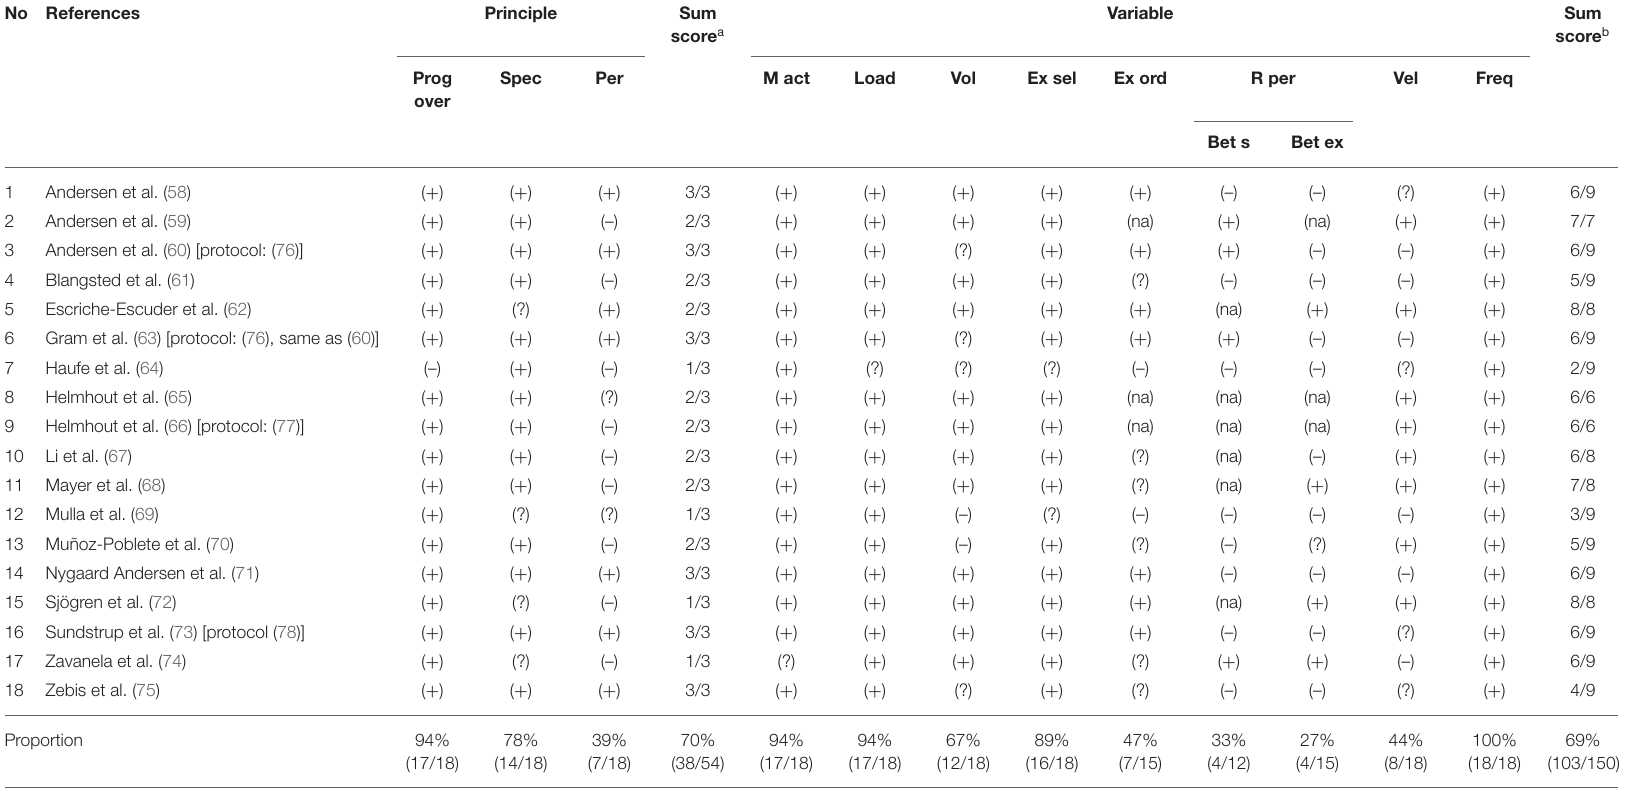
TABLE 4 | Application of principles of progression and variables of exercise